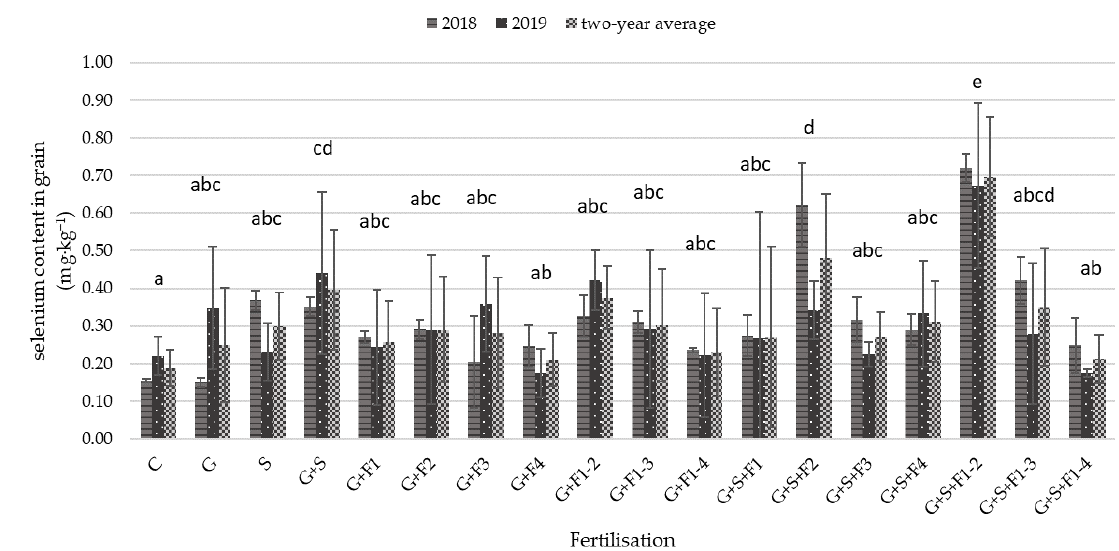
Figure 3. Average selenium content in grain depending on the type of fertilization, and homogenous groups for mean selenium content in grain from two years of the study. Values are mean ± standard error. a, b, c—Means followed by the same letter are not significantly different from one another based on Tukey’s test at p ≤ 0.05.